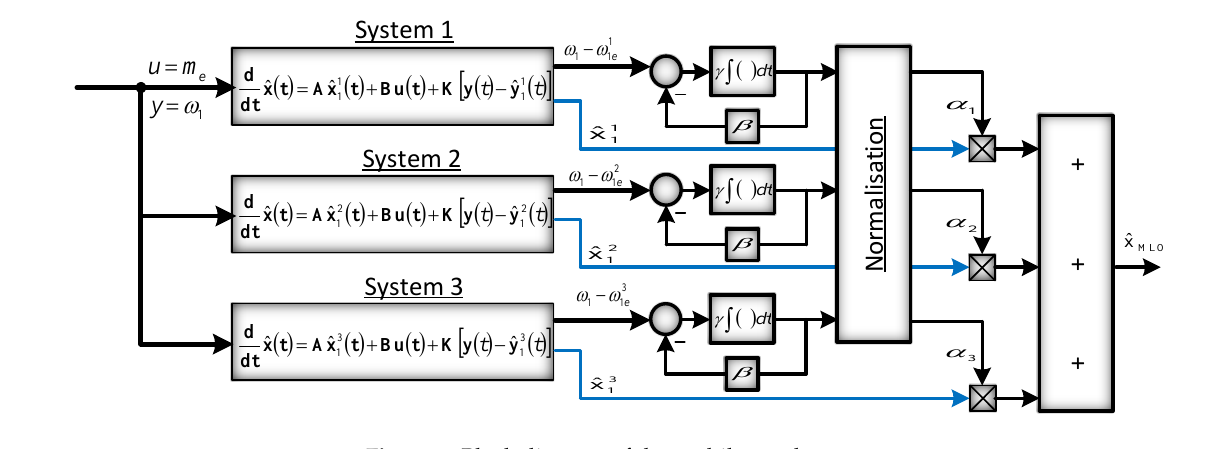
Figure 3. Block diagram of the multilayer observer.